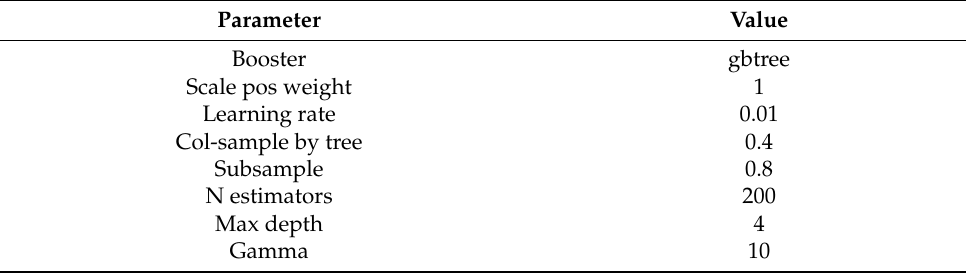
Table 1. Feature extraction with XGboost Tree-based decision model parameter.